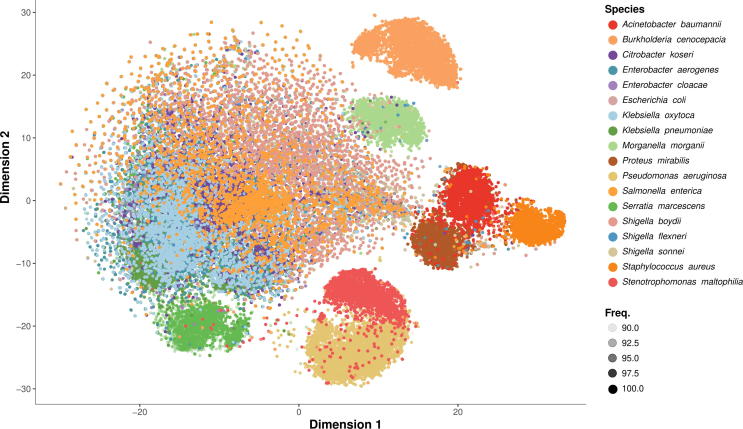
Two-dimensional embedding of pan-genome centroids per species Centroids with a isolate frequency ≥90% are shown. The respective species of the centroids’ source pan-genome were color coded.